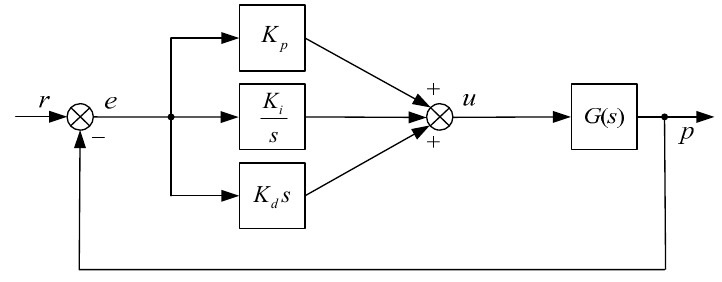
Figure 6. Structure diagram of PID controller.